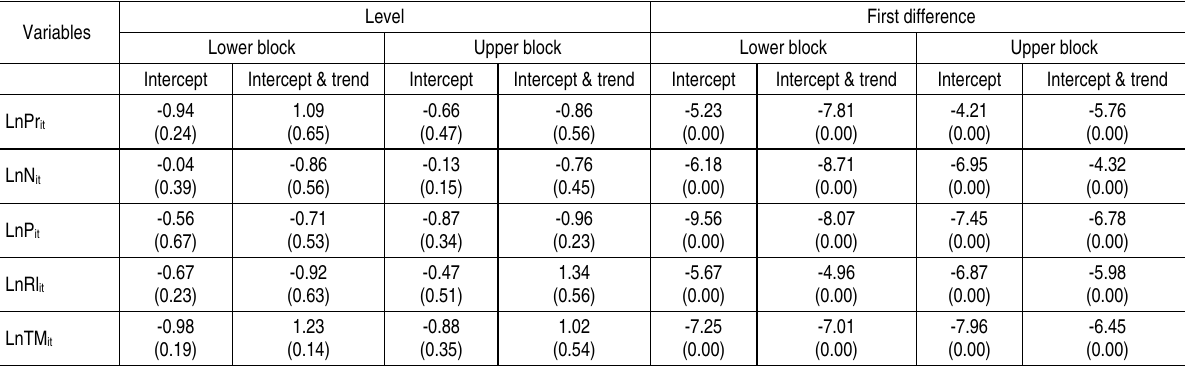
Table 4. Pesaran (2007) panel unit root test